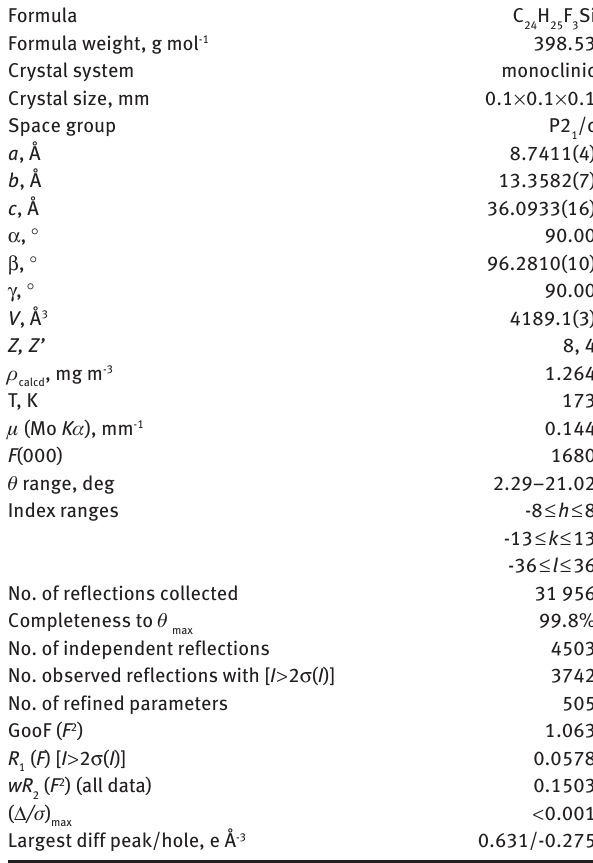
Table 1 Crystal data and structure refinement of monoclinic 2,6-Mes C H SiF 2 6 3 3